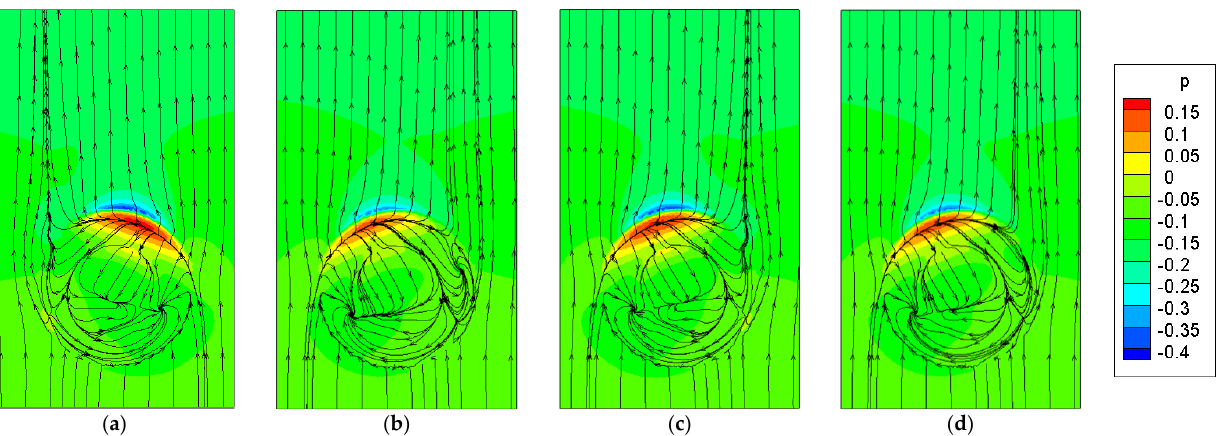
Figure 3. Calculated pressure fields and the source streamlines in the control area of the channel wall with the dimples for the considered standard SST models and the modified Menter SST models: ( a ) Menter 1993 SST model, ( b ) Menter 2003 SST model, ( c ) Menter SST model corrected according to RLI, and ( d ) Menter SST model corrected according to SM.